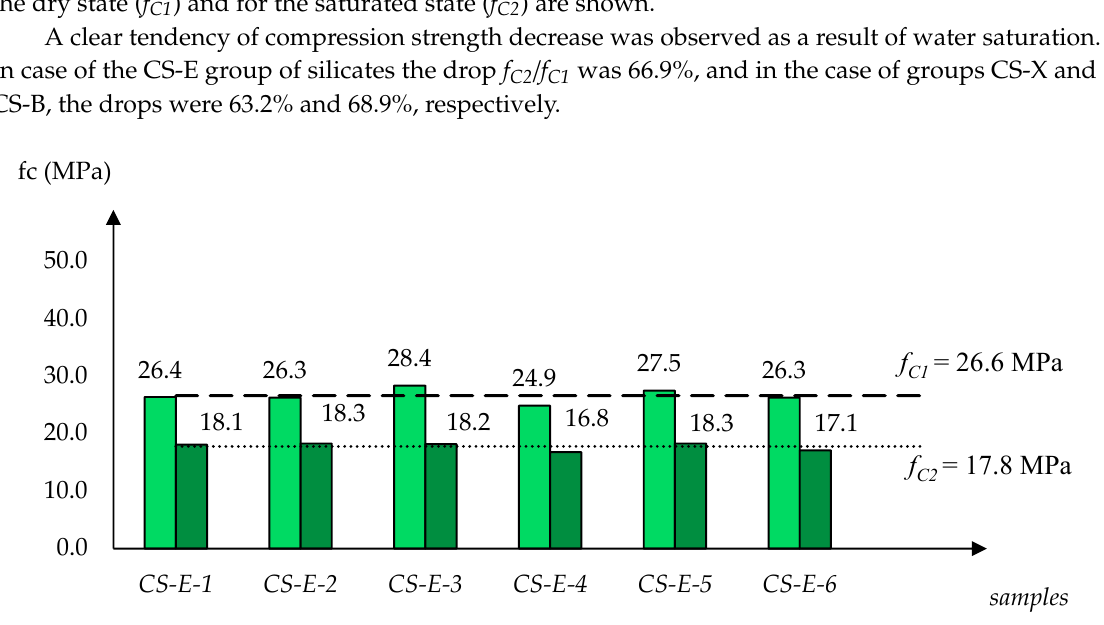
Figure 2. Overview of compressive strength values designated for silicate specimens CS-E-1–CS-E-6 (6 dry and 6 water-saturated), with f C1 (for dry state) and f C2 (for saturated state) averages.